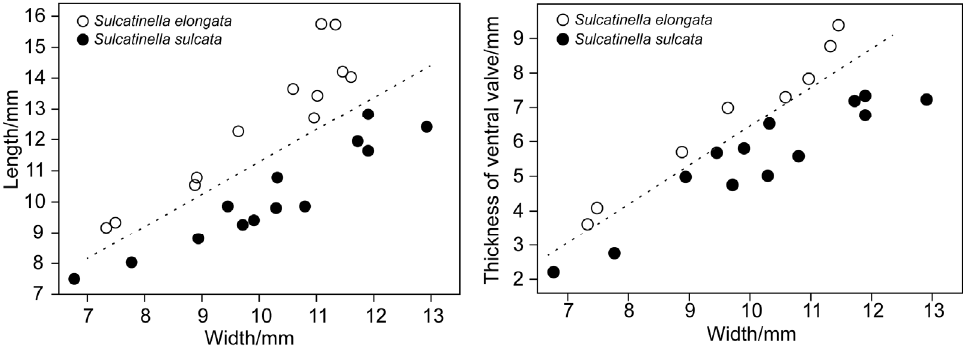
Figure 10. Graph of shell length to shell width and thickness of ventral valve to width of S. sulcata and S. elongata from the studied section.